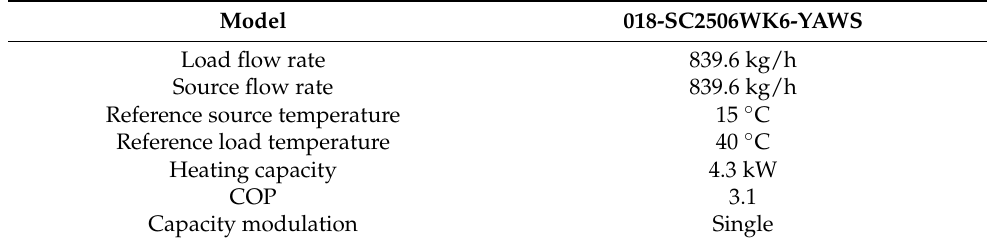
Table 4. Water-to-water HP specifications [35].